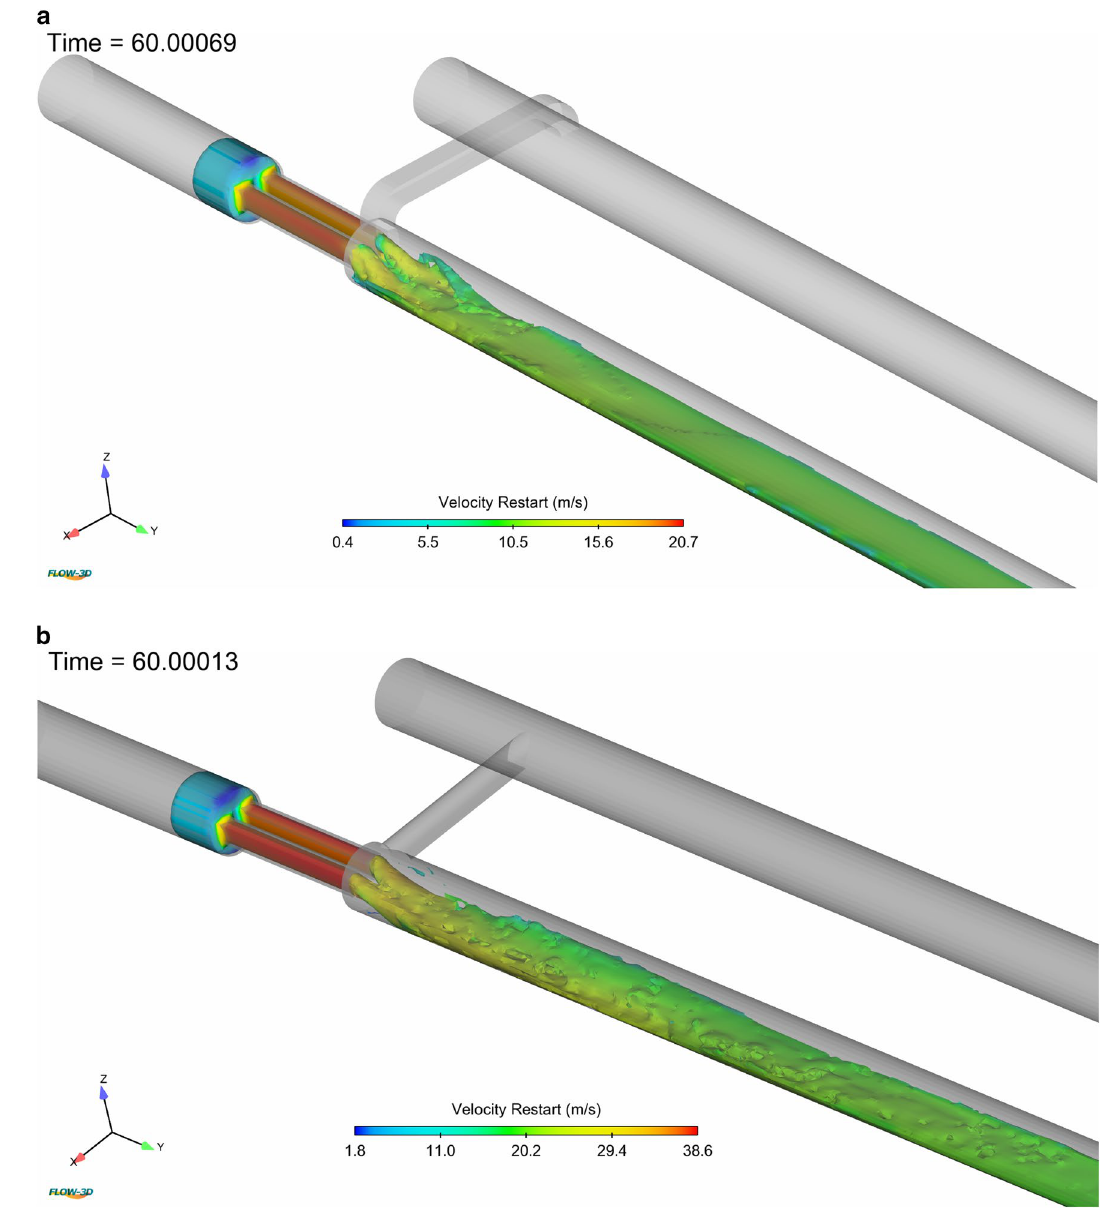
Fig. 14 Views from CFD analysis of enhanced designs: a EDN-1, b